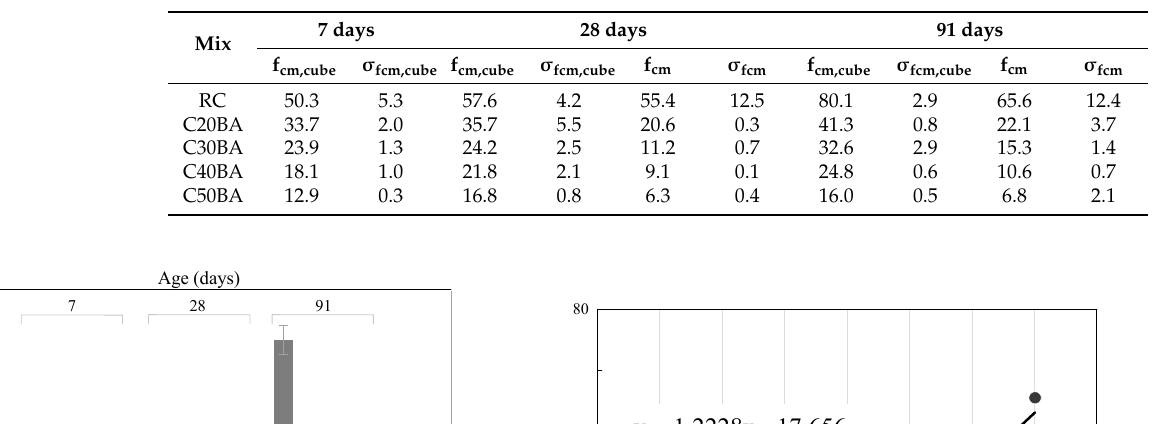
Table 5. Compressive strength in cylindrical at 28 days and 91 days and in cubes at 7 days, 28 days and 91 days.